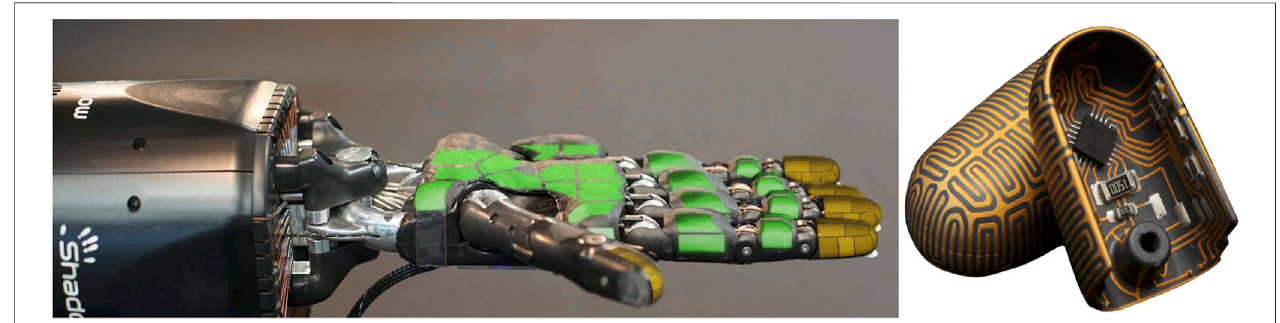
FIGURE2| Shadow-Dexterous-Handequippedwithfabrics-basedtactilesensorsinthepalmand fi ngerphalanges(indicatedgreen)and fi ngertipsensorsrealized by Molded-Interconnect-Devices (indicated yellow) (Koiva et al., 2013; Büscher et al., 2015).